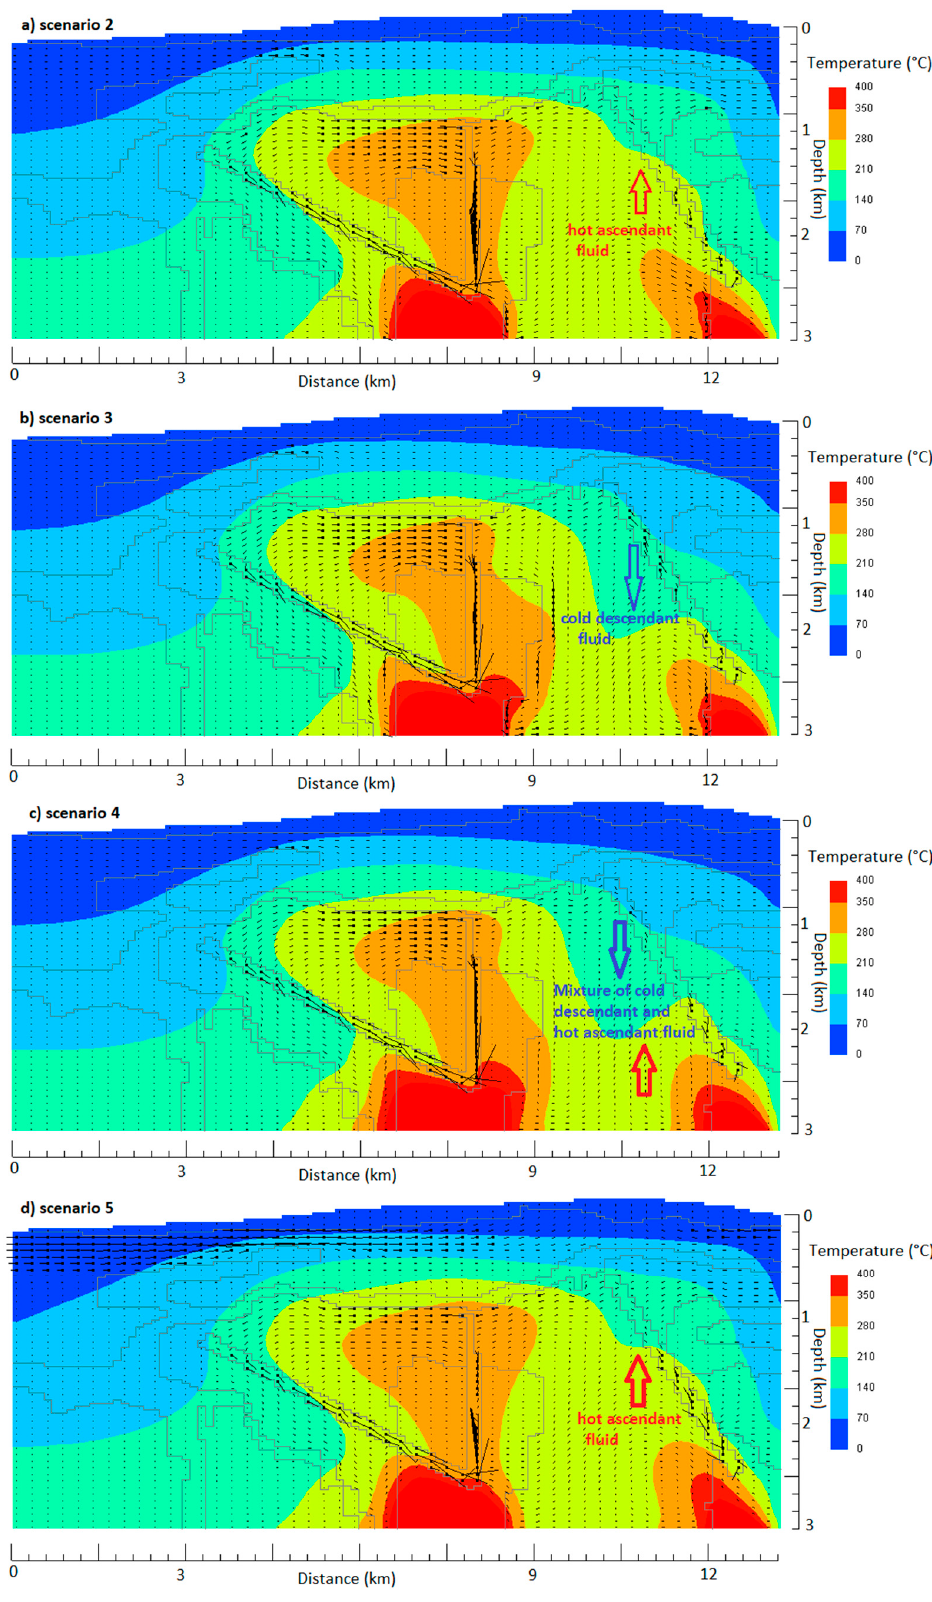
Figure 7. Simulated temperature and flow vectors at time equal to 100,000 years. The direction of flow is from the point to the end of the straight lines. The length of each line indicates the water vector magnitude, where 1.2 km = 1 × 10 − 5 g (s -1 cm -2 ).